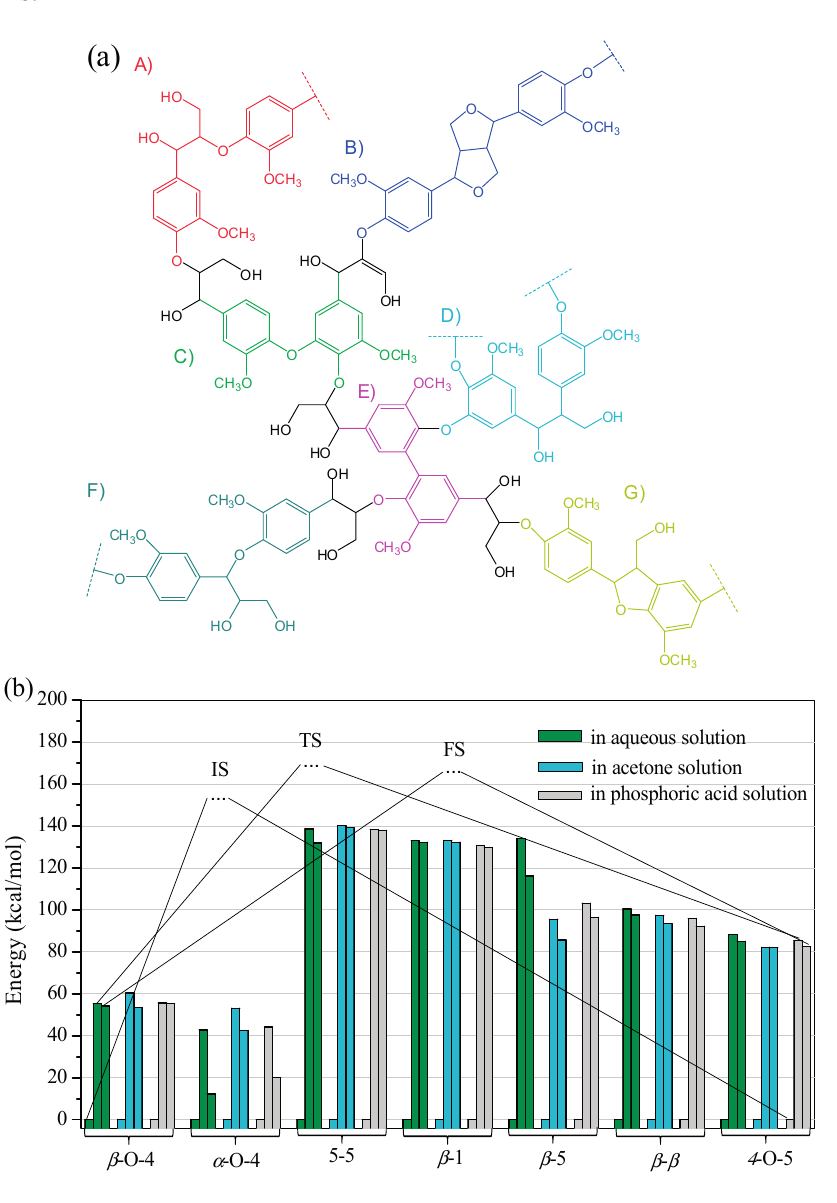
Figure 2. ( a ) Stable lignin fragment highlighting the linkages studied in this work: (A) β -O- 4; (B) β - β ; (C) 4 -O- 5; (D) β -1; (E) 5-5; (F) α -O- 4; and (G) β -5; ( b ) Potential energy profiles for the decomposition reaction of different linkages in H 3 PO 4 , CH 3 COCH 3 ,